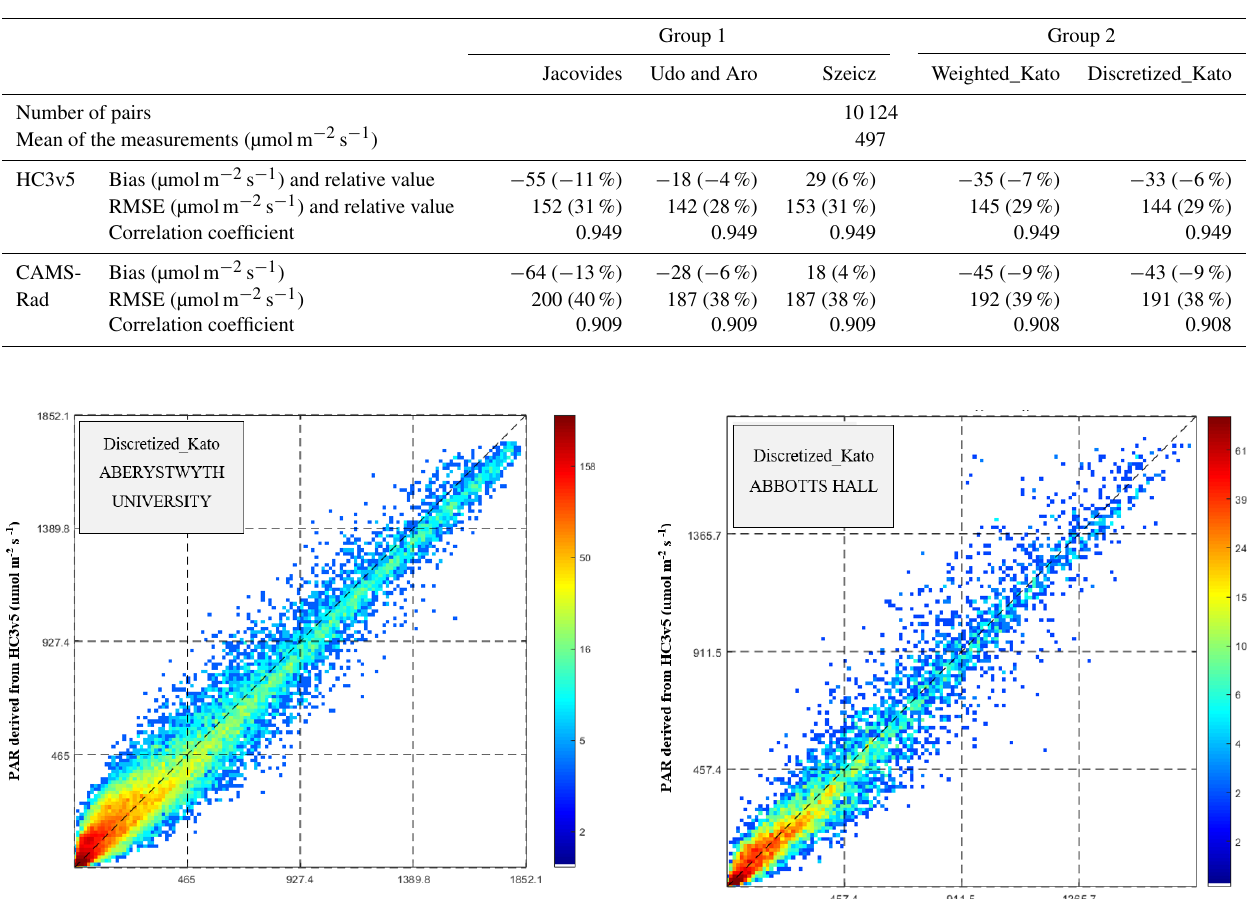
Table 4. Cartmel Sands. Number of coincident data, mean of measurements, bias and root mean square error (RMSE) and correlation coefficient for the five PAR-satellite methods and for both HC3v5 and CAMS-Rad data sets.